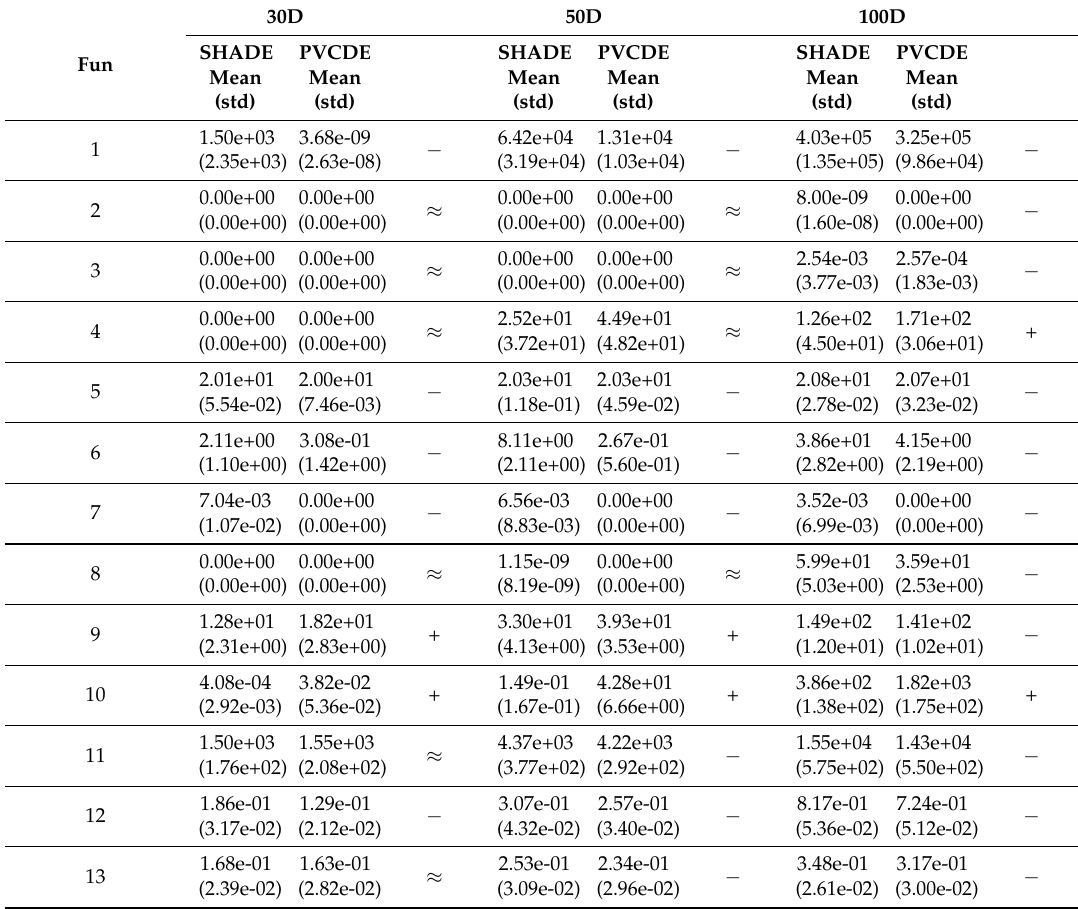
Table 4. CEC 2014 function test for 30D, 50D, 100D on SHADE and